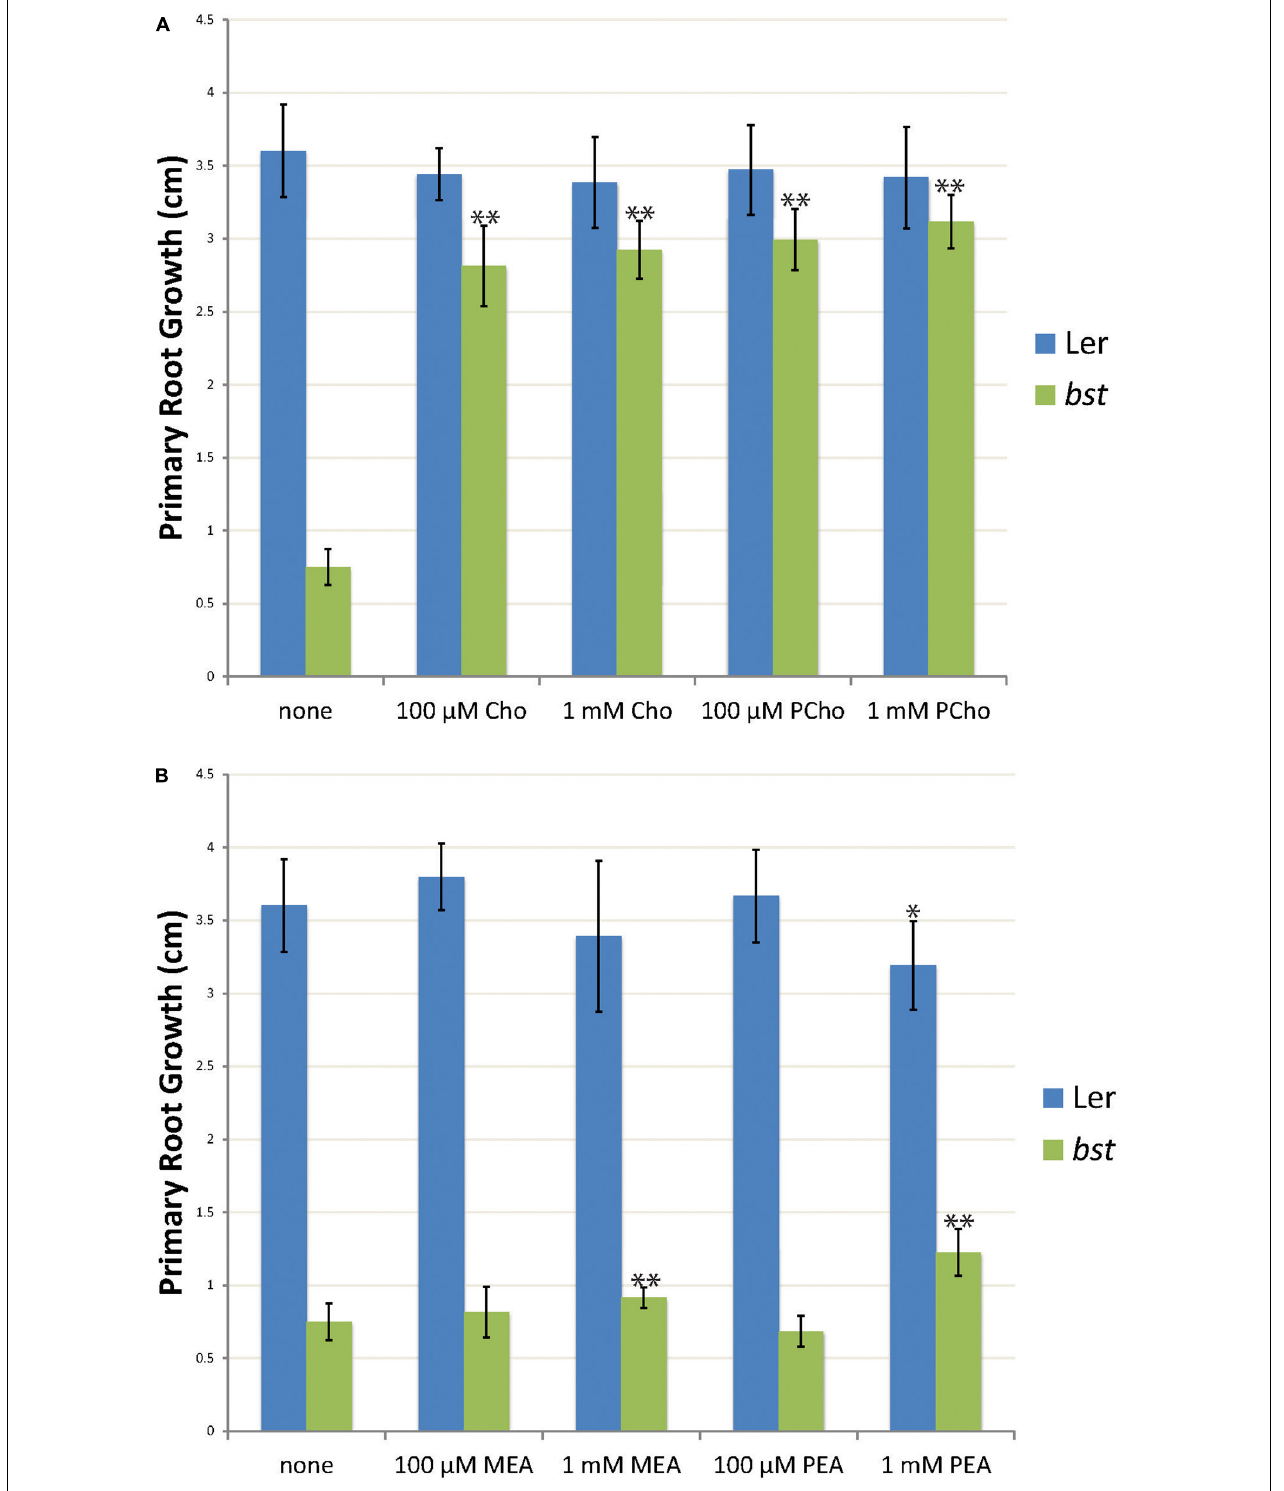
FIGURE 4 | The effects of choline, phosphocholine, ethanolamine, and phosphoethanolamine supplementation on root growth. Three day old seedlings were transplanted to plates containing choline (Cho) or phosphocholine (PCho) (A) or ethanolamine (MEA) or phosphoethanolamine (PEA) (B) . Primary root growth was measured after seven days of growth. The root length of treated plants was compared to untreated plants of the same genotype using unpaired t -tests. “*” indicates a p -value < 0.01 and “**” indicates a p -value < 0.001. Error bars are SD.